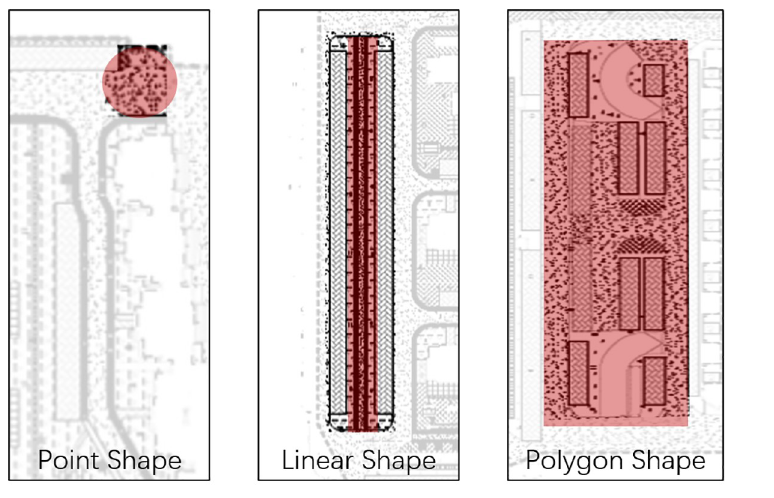
Fig 3. Geometric shapes of small public